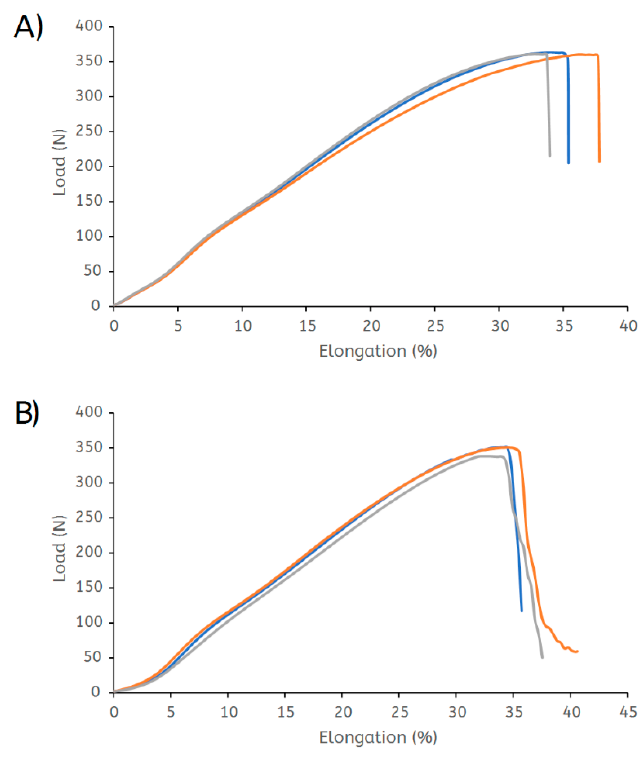
Figure 8. Tensile curves of ( A ) virgin and ( B ) recycled polyester.